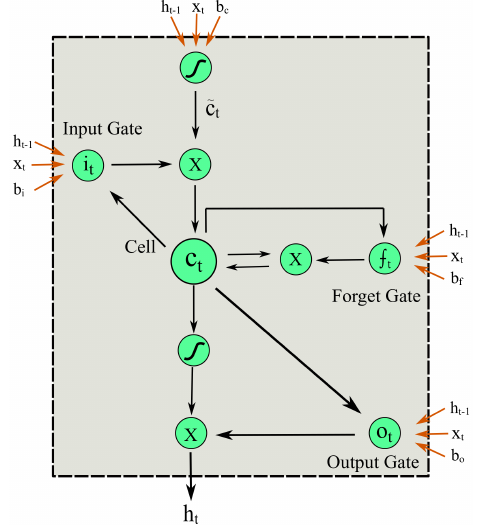
Figure 2. The internal structure of an LSTM